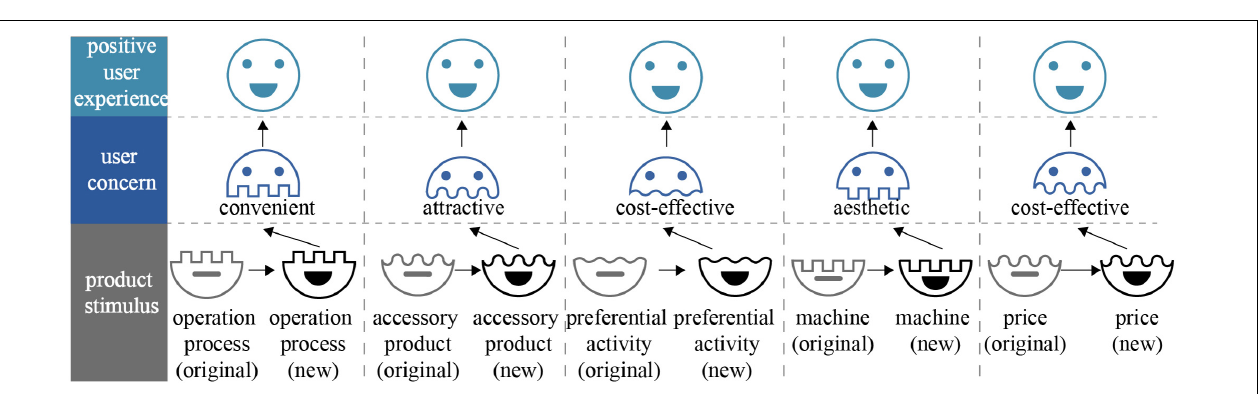
FIGURE 11 | Improvement direction around “Angel Orange” unmanned retail